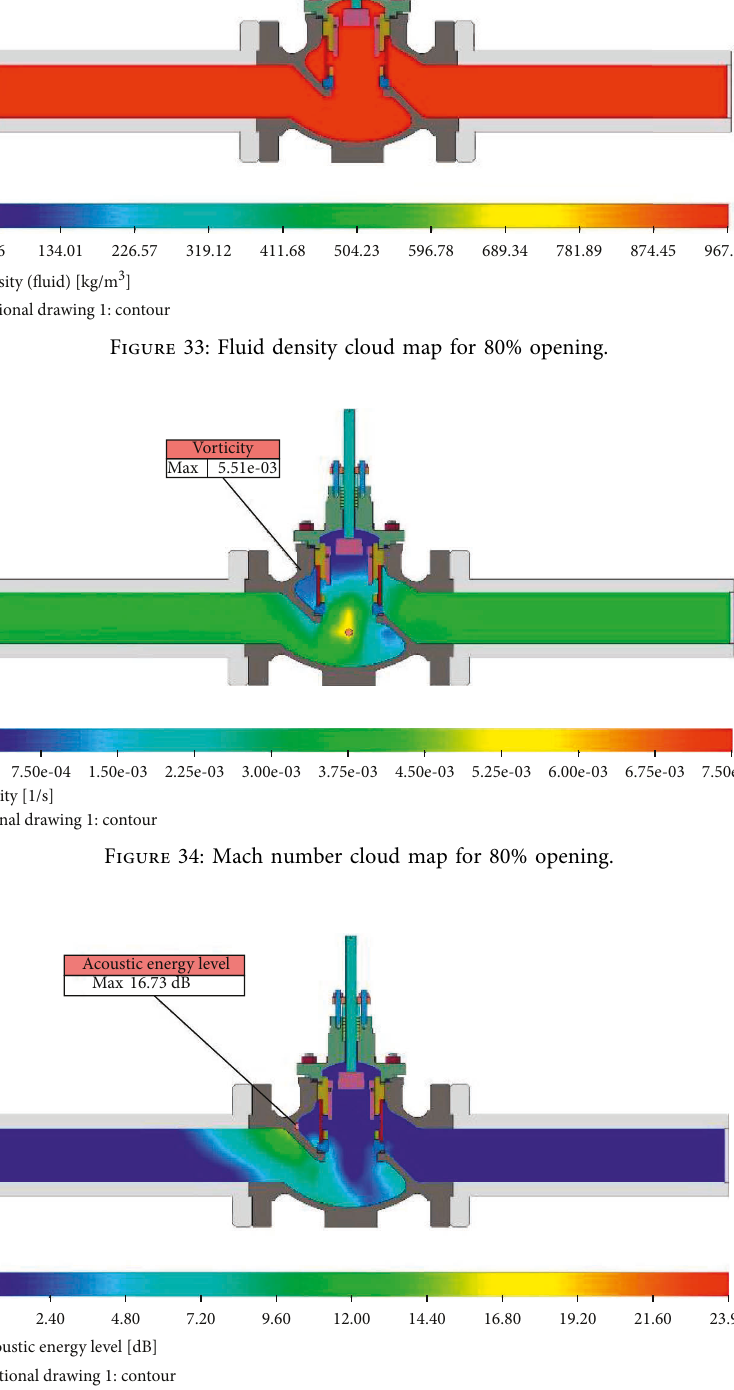
Figure 35: Acoustic energy level cloud map for 80%